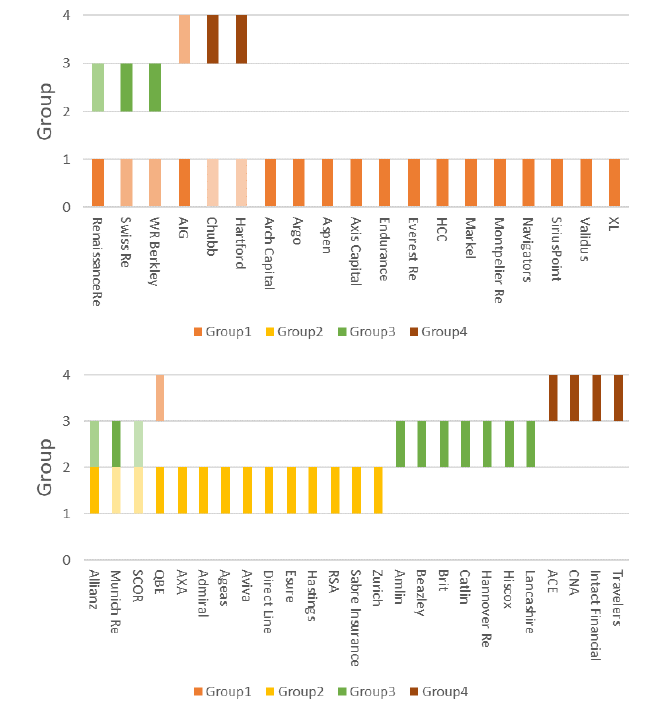
Figure 6. Allocations of different insurers across the 4 identified